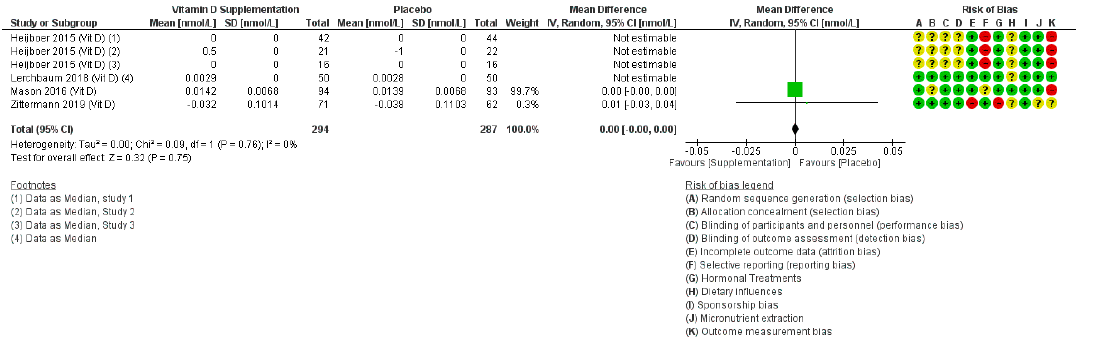
Figure 4. Forest plot assessing e ff ects of increasing vitamin D on free testosterone (nmol / L). Vit D, vitamin D. Please refer to Supplementary Table S5, E to find detailed information on the studies and reference